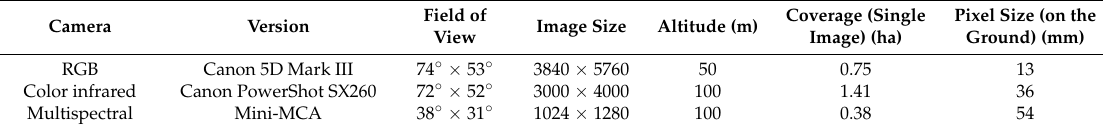
Table 2. Technical specifications of the three cameras and image captures from the